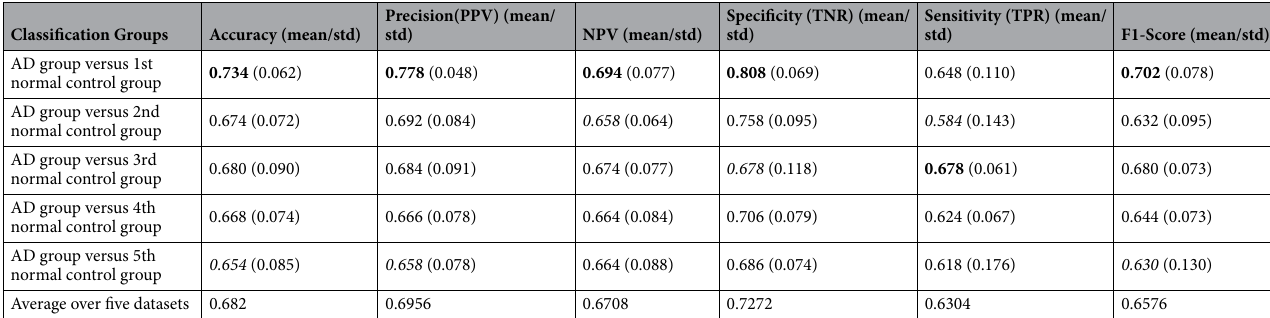
Table 2. Performance comparison of the overall classification for AD versus normal controls (NC)* without feature selection . *The mean and standard deviation values were extracted from five-fold cross validations. Bold font represents the most optimal performance for each measurement among five-fold cross validations. Italic font represents the least optimal performance. Abbreviation: AD = dementia caused by Alzheimer’s disease, NC = normal control, PPV = positive predictive value, NPV = negative predictive value, TNR = true negative rate, TPR = true positive rate.